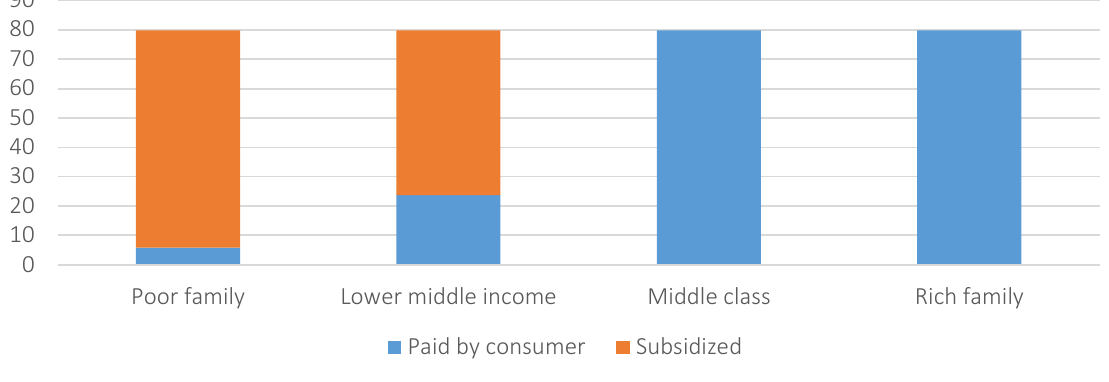
Figure 4. Four cases of utilities rate structure in Ukraine for the same apartment, euros